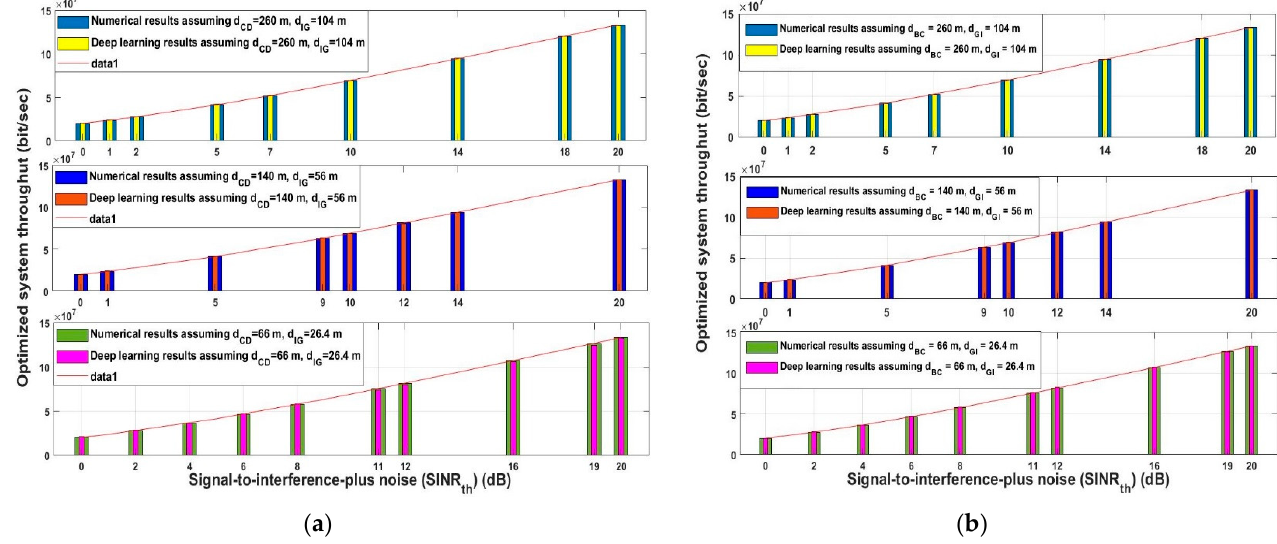
Figure 9. Signal-to-interference-ratio-plus-noise (SINR th ) versus optimized system throughput ( a ) uplink ( b ) downlink.